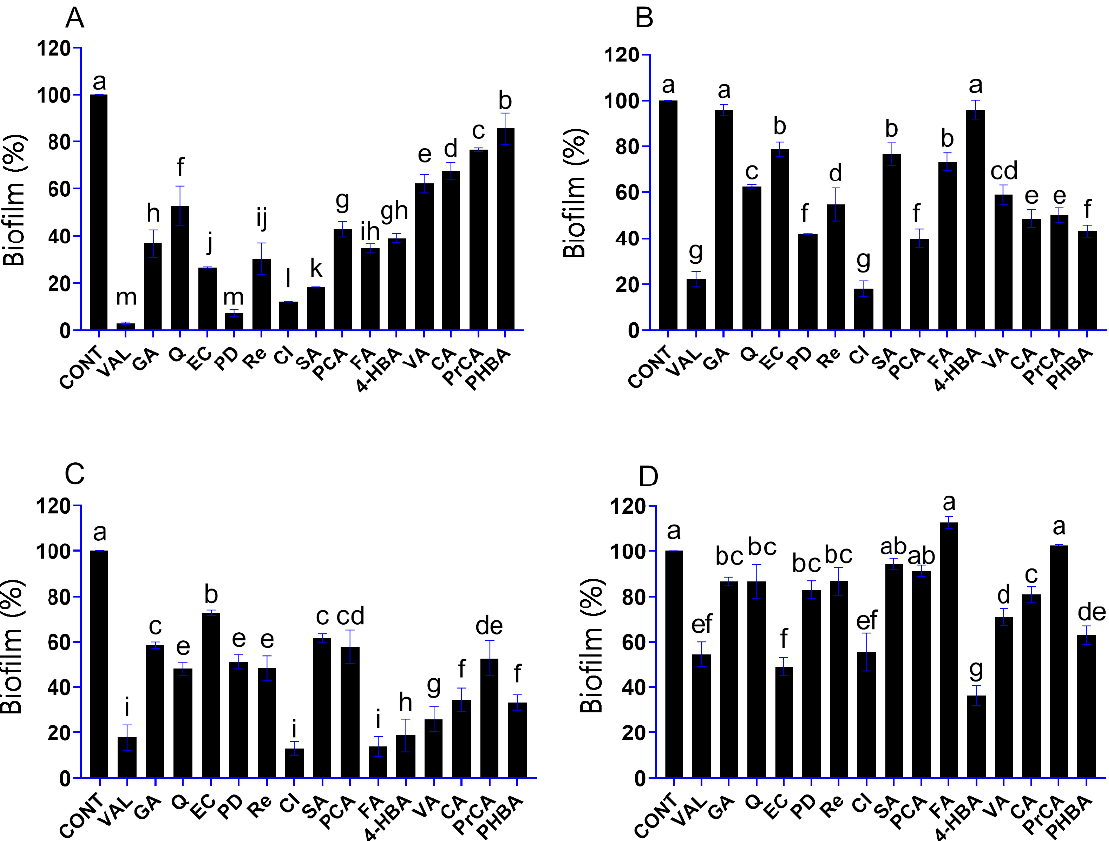
Figure 1. Effect of phenolic compounds (in 500 µ g/mL) on the biofilm formation of D. hansenii SZMC 8045Mo ( A ), P. anomala SZMC 8061Mo ( B ), S. pombe SZMC 1280 ( C ) and S. cerevisiae SZMC 1279 ( D ). Phenolic compounds: vanillin, VAL; gallic acid, GA; quercetin, Q; (-)-epicatechin, EC; polydatin, PD; resveratrol, Re; cinnamic acid, CI; syringic acid, SA; p -coumaric acid, PCA; ferulic acid, FA; 4-hydroxybenzaldehyde, 4-HBA; vanillic acid, VA; caffeic acid, CA; protocatechuic acid, PrCA; 4-hydroxybenzoic acid, PHBA. The control (CONT) represents the biofilm formation in the absence of phenolic compounds. The results shown are the mean percent biofilm formed relative to control biofilm; error bars represent standard deviation. The different letters above the columns indicate significant differences according to one-way ANOVA followed by Tukey’s multiple comparison test ( p < 0.05).